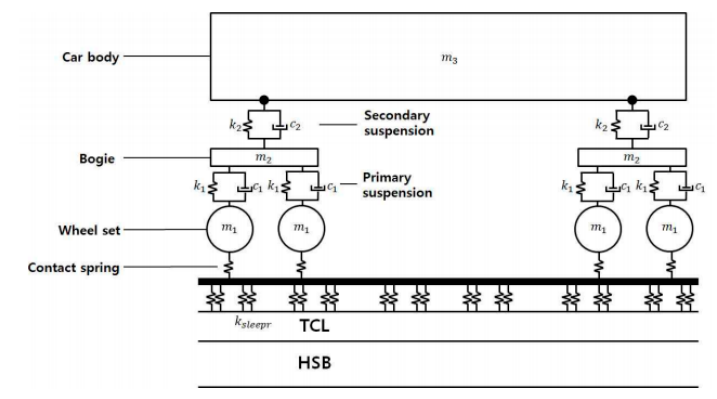
Figure 12. Moving load of the vehicle including suspension system.